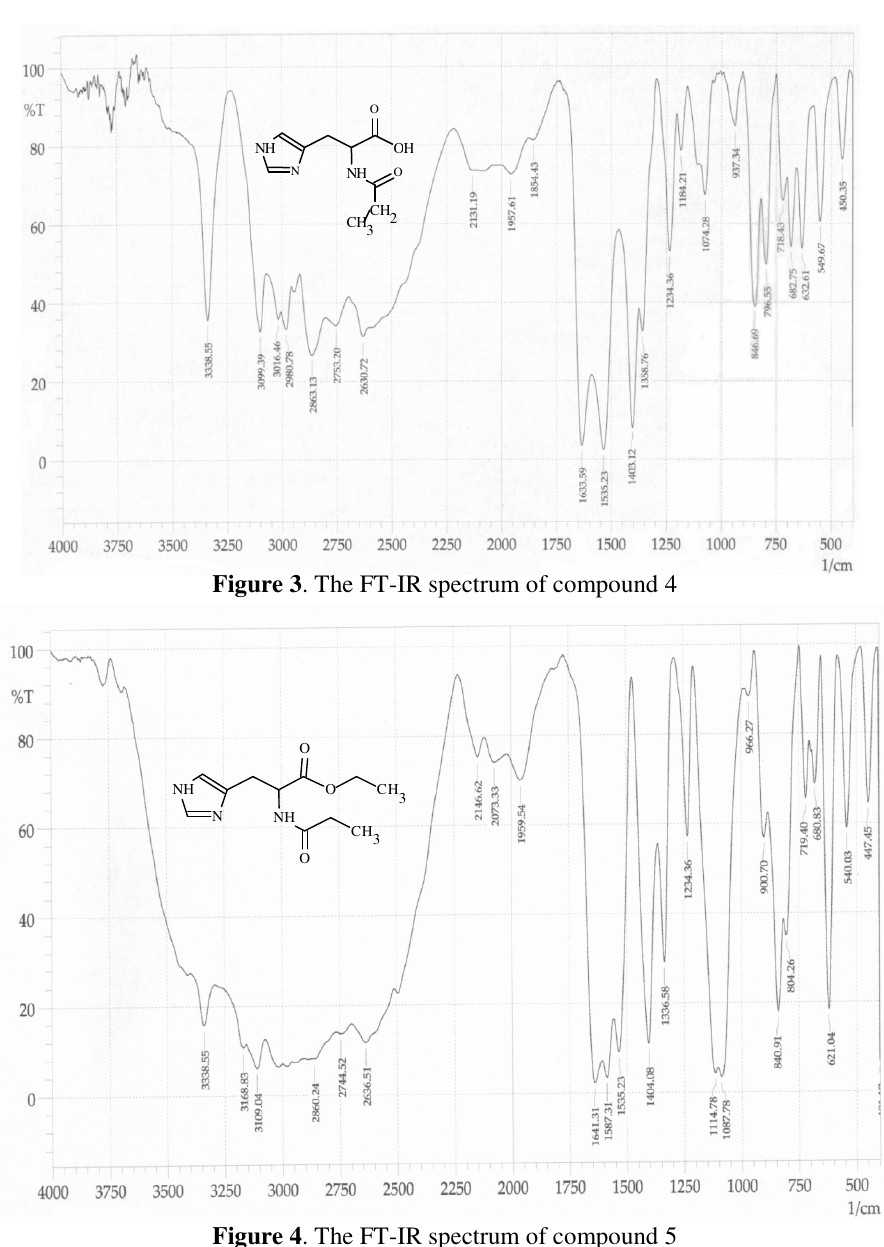
Figure 4 . The FT-IR spectrum of compound